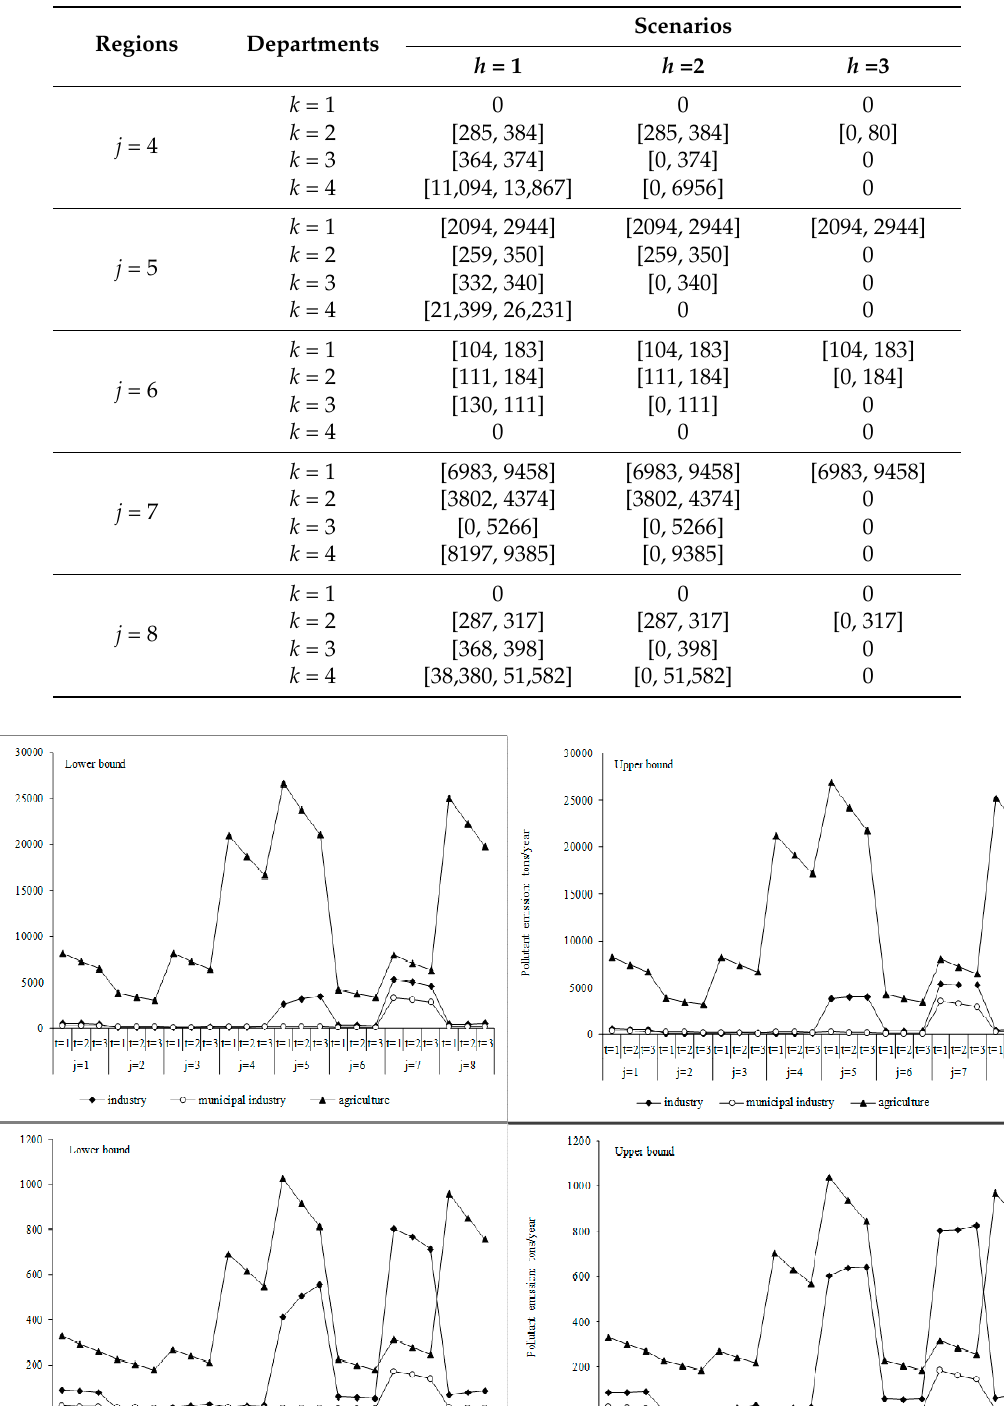
6000 40005000 Figure 7. Relationships between carrying capacity of COD and quantity inlets to the Yinma River. For the purpose of water environment protection, pollutant quantities discharged into the river should not exceed the environmental carrying capacity. Figures 7 and 8 show the relationships between pollutant emission load and environmental carrying capacity for COD and NH 4 -N, respectively. The figures reveal that the amounts of pollutant discharged into the river decreased over time, because of reductions in regional pollutant emissions. However, the amounts were still far in excess of the environmental carrying capacities. For example, in Zone 9, the amounts of COD discharged into the river 0 10002000 3000